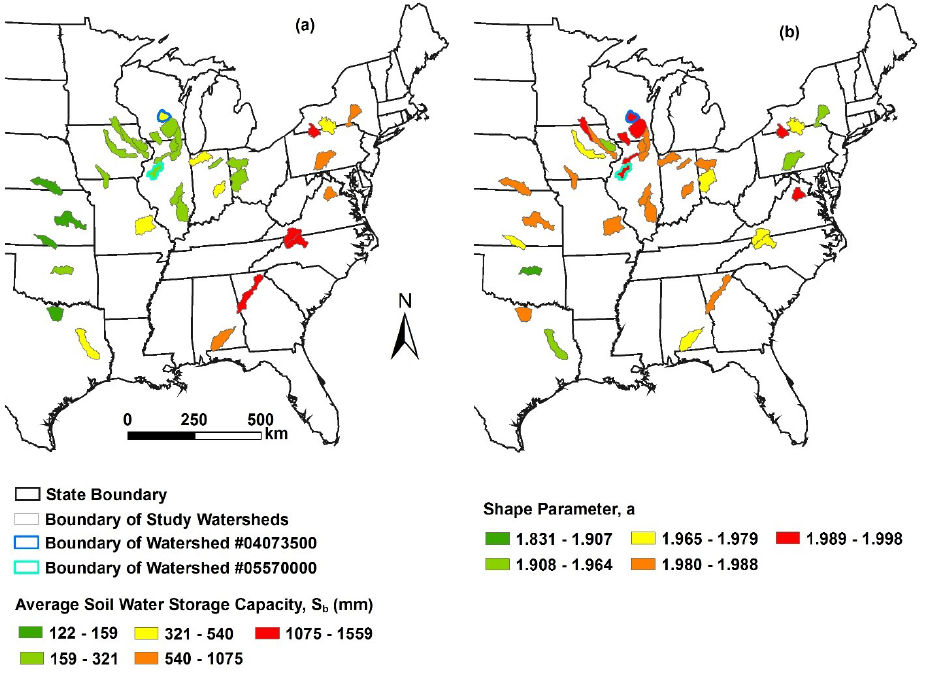
Figure 4. The estimated average soil water storage capacity ( S b ) as a function of S CN and climate aridity index (a) and shape parameter from soil data (b) .